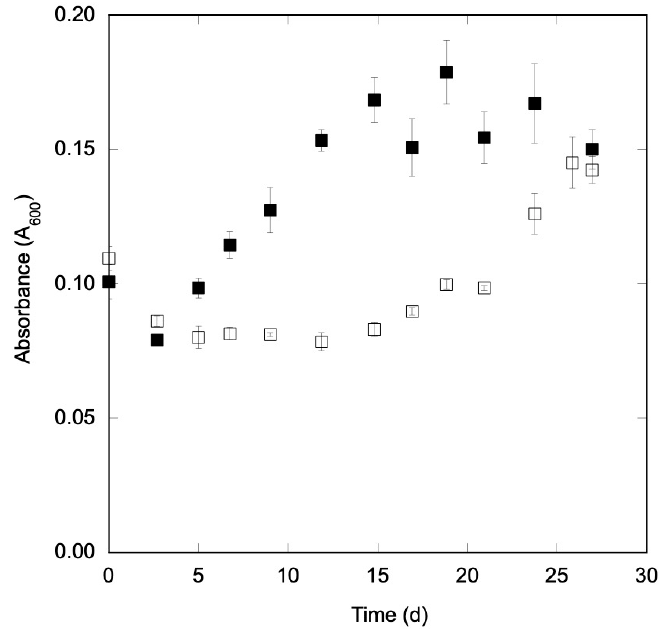
Figure 1. Growth (A 600 ) of Moorella glycerini DSM 11254 T with a headspace containing 30% carbon monoxide with (solid squares) or without (open squares) 20 mM perchlorate. Values represent means of triplicates ± 1 standard error.